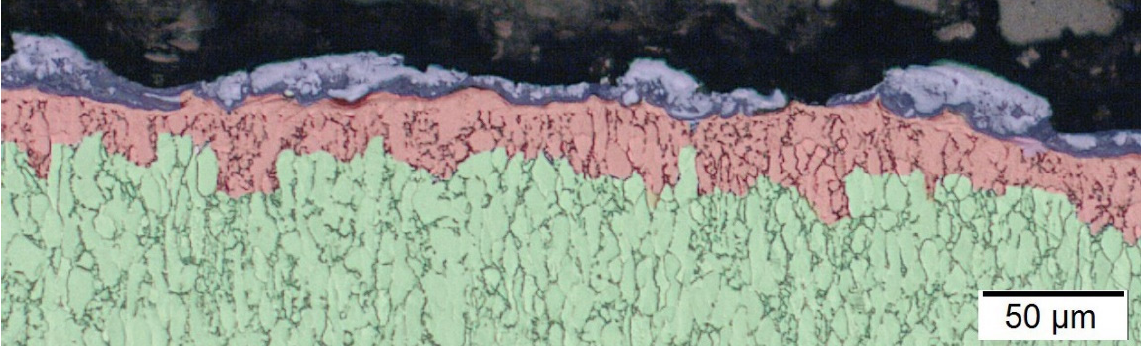
Figure 1. Microstructure evaluation of Titanium Grade 23 machined by EDM.